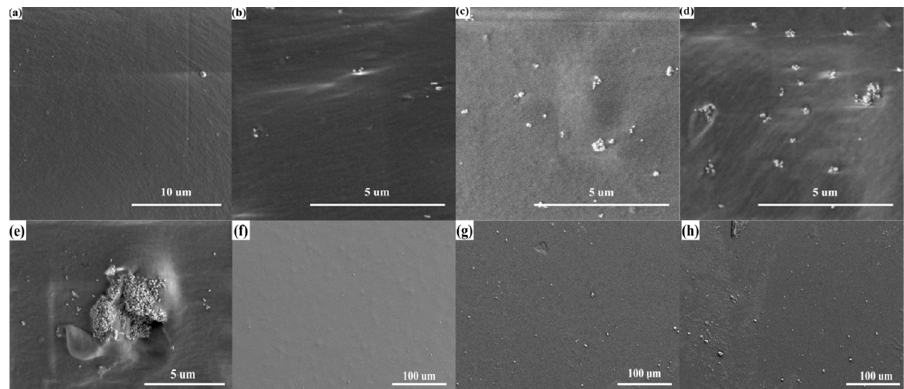
Figure 3. SEM images of the dielectric layer. ( a ) The cross-section of pure PDMS film; and ( b – d ) composite film with BaTiO 3 content of 10%, 20%, and 30%, respectively. ( e ) Agglomeration of BaTiO3 particles. ( f – h ) The surface of composite film with BaTiO 3 content of 10%, 20%, and 30%. A three-electrode measurement system (Shanghai Anbiao Electronics Co., Ltd.,